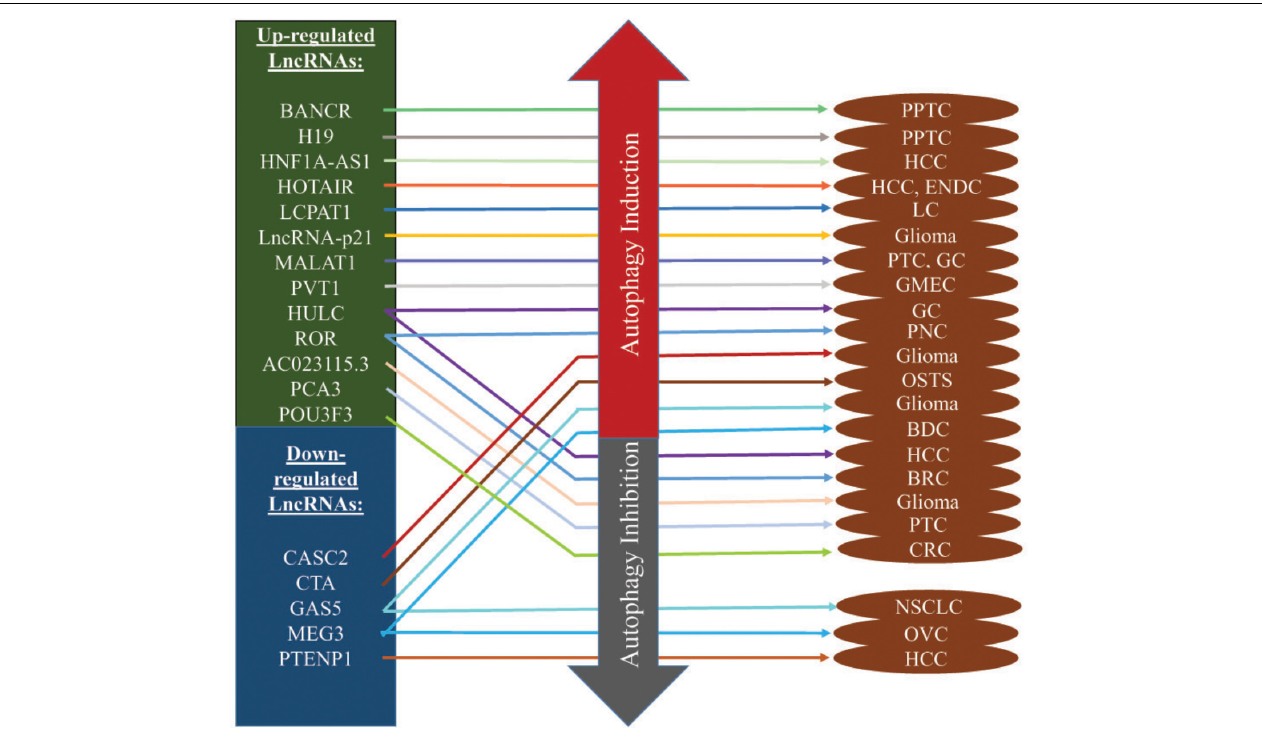
FIGURE 3 | Autophagy-modulating lncRNAs in cancer. Most of the lncRNAs are overexpressed and they induce autophagy to promote/inhibit carcinogenesis. Some of them play key roles in drug resistance while some inhibit autophagy to maintain homeostasis in cancer micro-environments. In the contrary, down-regulated lncRNAs induce/suppress autophagy to promote/inhibit cancer